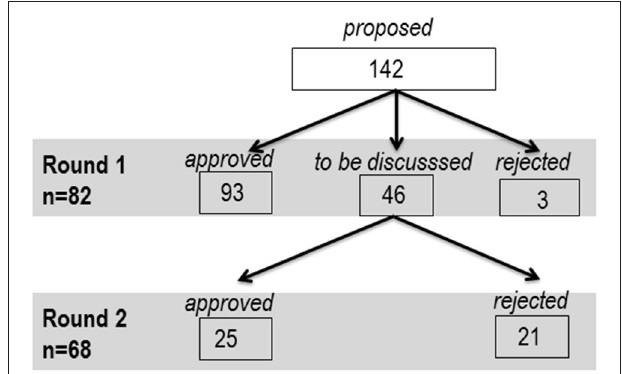
FIGURE 4 | Flowchart for items endorsement/rejection per round and